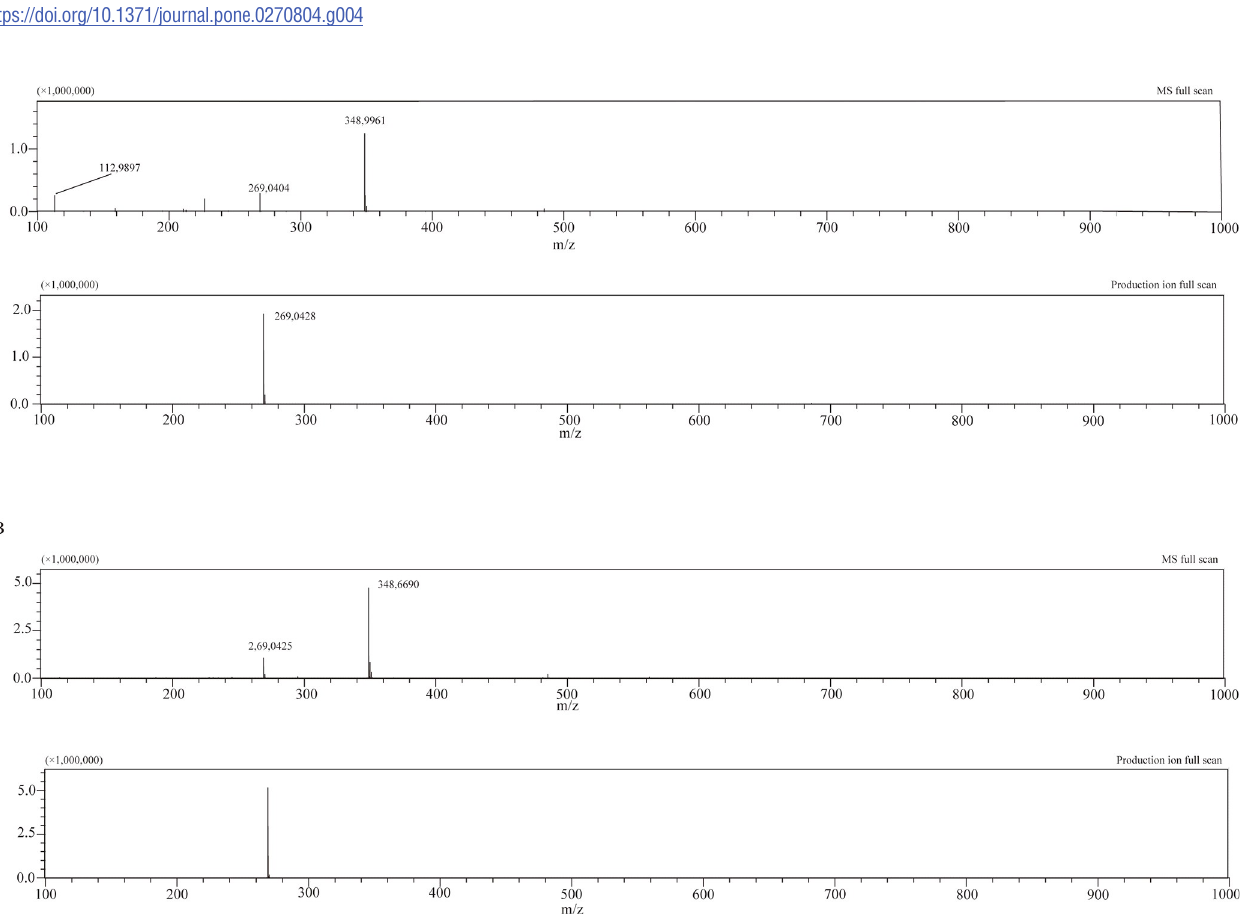
Fig 5. Negative ion mass-spectrometry (MS) spectra and tandem MS product ions spectra of genistein metabolite and genistein-7-sulfate of sw SULT ST3. Analysis of the genistein metabolite (A) and genistein-7-sulfate (B) was carried out. Each panel includes the result of MS full scan and production ion scan at m/z